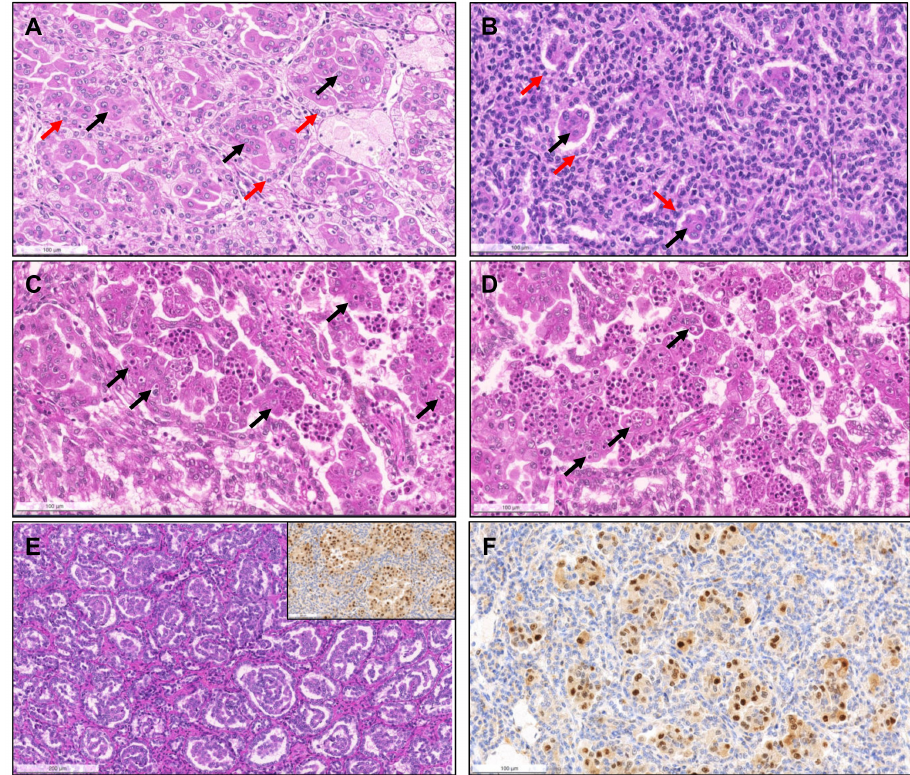
Figure 4. Biphasic squamoid/alveolar RCC pattern. Alveolar structures lined by smaller cells (red arrows) with scant cytoplasm and lower nuclear grade surround nests of larger cells (black arrows), with squamoid-like cytoplasmic features and higher nuclear grade, creating a biphasic and glomeruloid-like appearance, that was more prominent ( A ) or more discrete ( B ). Emperipolesis (engulfment of hematopoietic cells or parts of cells) were seen in most tumors with this pattern (( C , D ), arrows). This pattern was also documented in a patient with a non-encapsulated tumor with less than 1.5 cm, meeting criteria for papillary adenoma ( E ). CyclinD1 immunoexpression was confirmed in all cases, restricted to the large cell population, highlighting them (inset in ( E , F )).